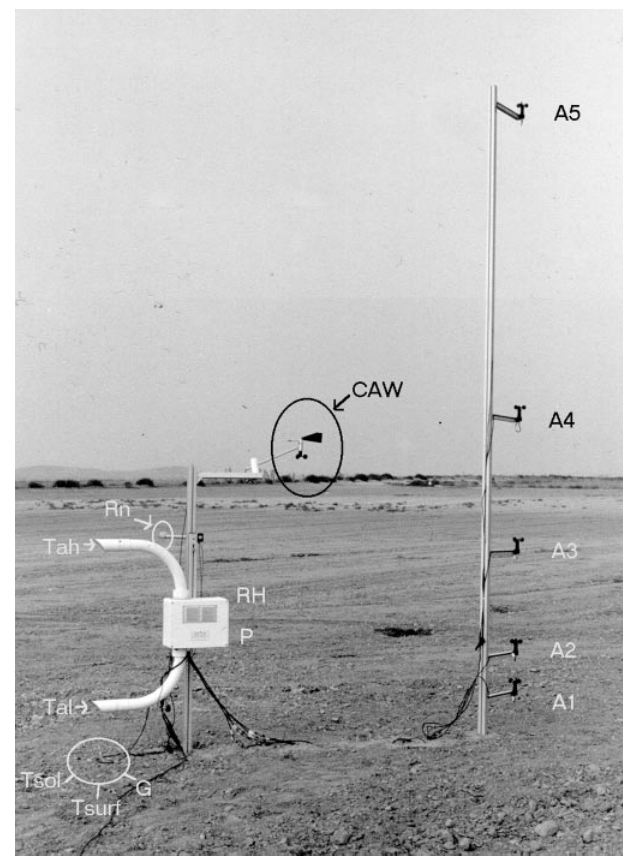
Fig. 2. Two micrometeorological ground stations (MGS) were set up during the WELSONS experiment. The wind profile, recorded every second, is measured with 5 cup anemometers marked A1 , A2 , A3 , A4 and A5 along a vertical mast 4 m in height ( right side of picture), near the station which is a datalogger with sensing and computing functions. Other measured parameters, radiative and thermodynamic data for the determination of the energy budget, are the following (3 min-measurements and 30 min-means): wind speed and direction by a cup anemometer and wind wane marked CAW on the figure; the net radiation flux sensor is Rn ; Tsol , Tsurf and G are respectively the soil temperature probe, the surface temperature probe and the ground heat flux sensor. All these sensors are buried, except the surface temperature probe which is very close to the soil surface; in fact, this probe is laid on the soil surface and covered with a fine layer of sifted soil. The soil temperature probe has been placed at the same depth as the ground heat flux plate. Air temperature and air relative humidity are measured at two levels from an alternative air aspiration system as described by Cellier et al . (1993). In the figure, Tal is the air temperature at the lower level, Tah the one at the upper level, and RH the relative humidity of the air measured in the captor chamber. To allow stabilization of air temperature and humidity sensors, no measurements of these parameters is made during the first 45 s following the inversion. The atmospheric pressure sensor is inside the station. Precise makes of instruments are specified in Table 3